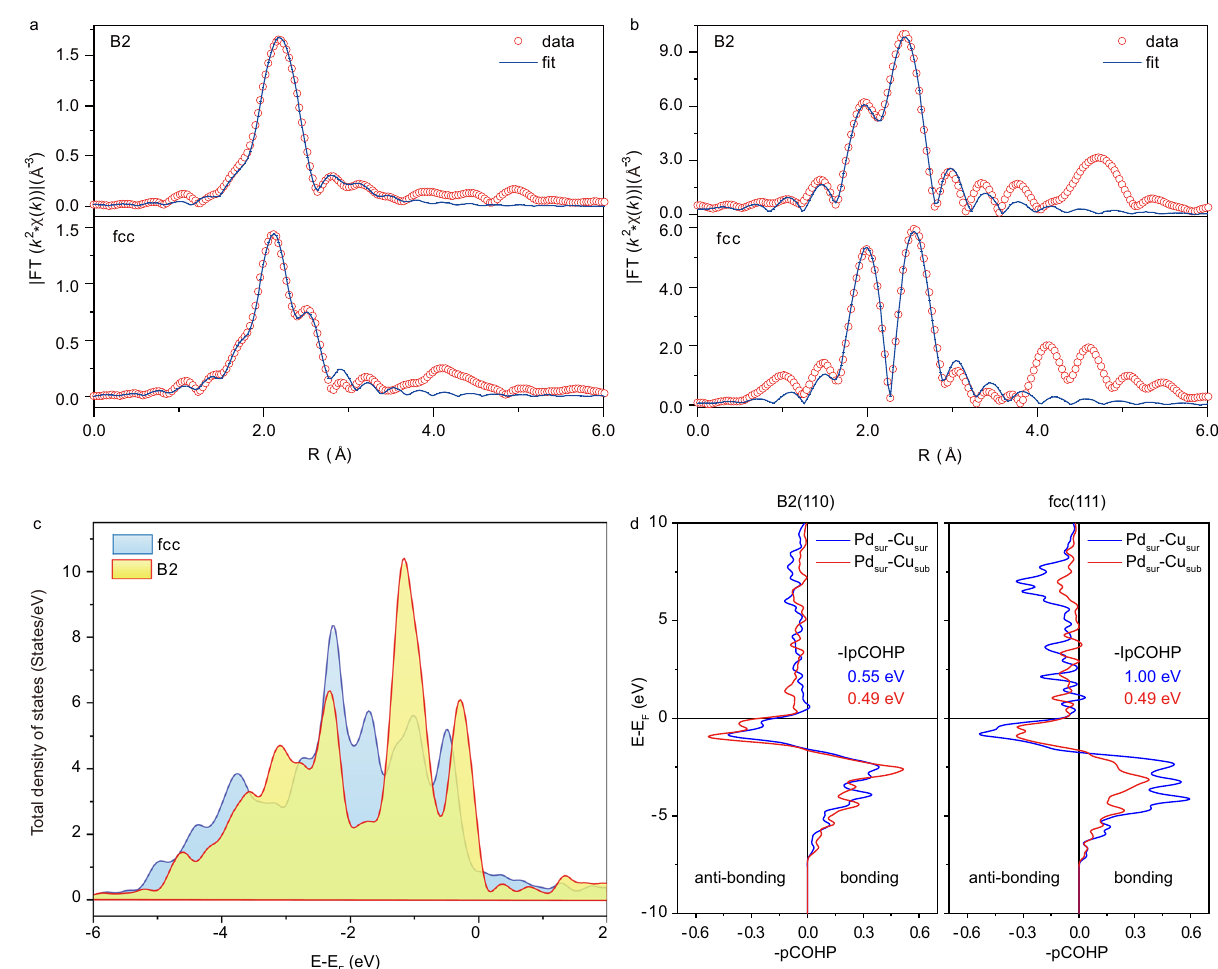
Fig. 3 | Bonding environments of Pd and Cu atoms in the PdCu nanoparticles. a , b k 2 -weighted Fourier transformed EXAFS spectra of Pd ( a ) and Cu ( b ) K-edges; theredcirclesshowtheexperimentaldatawhilethebluecurvesindicatethe fi tting results. c Total density of states per PdCu formula, showing the upshift of the B2